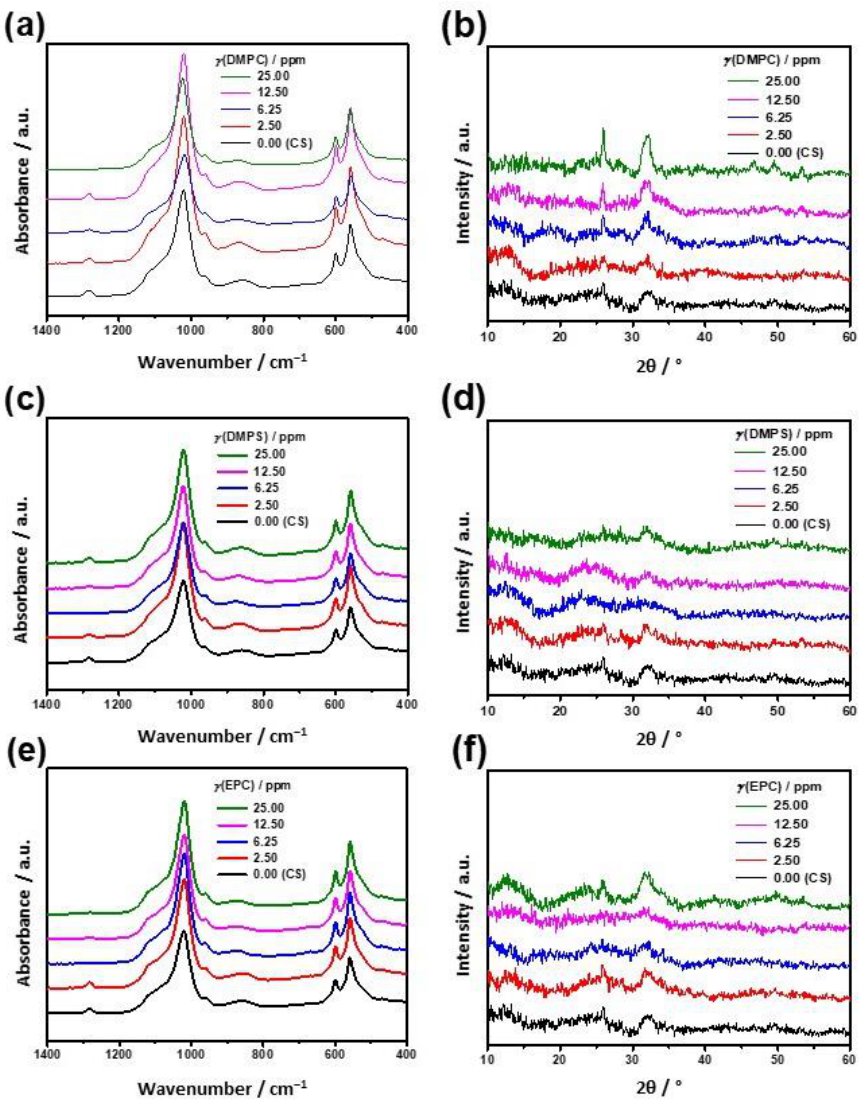
Figure 3. FTIR spectra ( a , c , e ) and PXRD patterns ( b , d , f ) of the CaP precipitate formed after 60 min of aging in the absence (CS) and presence of different concentrations of liposomes (expressed as lipid concentration): ( a , b ) DMPC, ( c , d ) DMPS, and ( e , f ) EPC. c i (Ca) = c i (PO 4 ) = 3.5 mmol dm −3 ; pH i = 7.4; ϑ /°C = 25 ± 0.1.